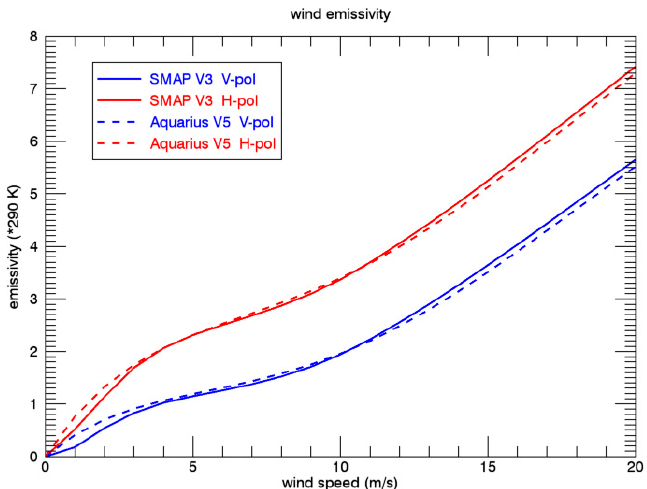
Figure 18. Isotropic (wind-direction independent) part of the wind induced emissivity that is used in the Aquarius Version 5 after interpolating to the SMAP Earth Incidence Angle (dashed lines) and the SMAP Version 3 (full lines) releases. Blue: V-pol. Red: H-pol. The figure shows the 0th harmonic of the wind induced excess emissivity [3,12] multiplied by 290 K.